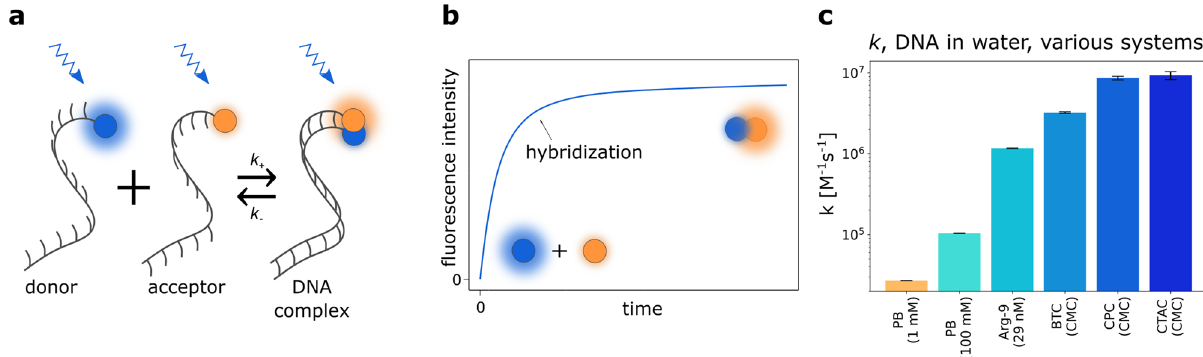
Fig. 5 | Second reaction model – DNA hybridization. a Model reaction between two DNA oligonucleotides (13 base pair each), one labeled with ATTO488 fl uor- ophore (donor), and second with ATTO647N (acceptor). b Double strand forma- tion was accompanied by an increase in fl uoresence intensity of